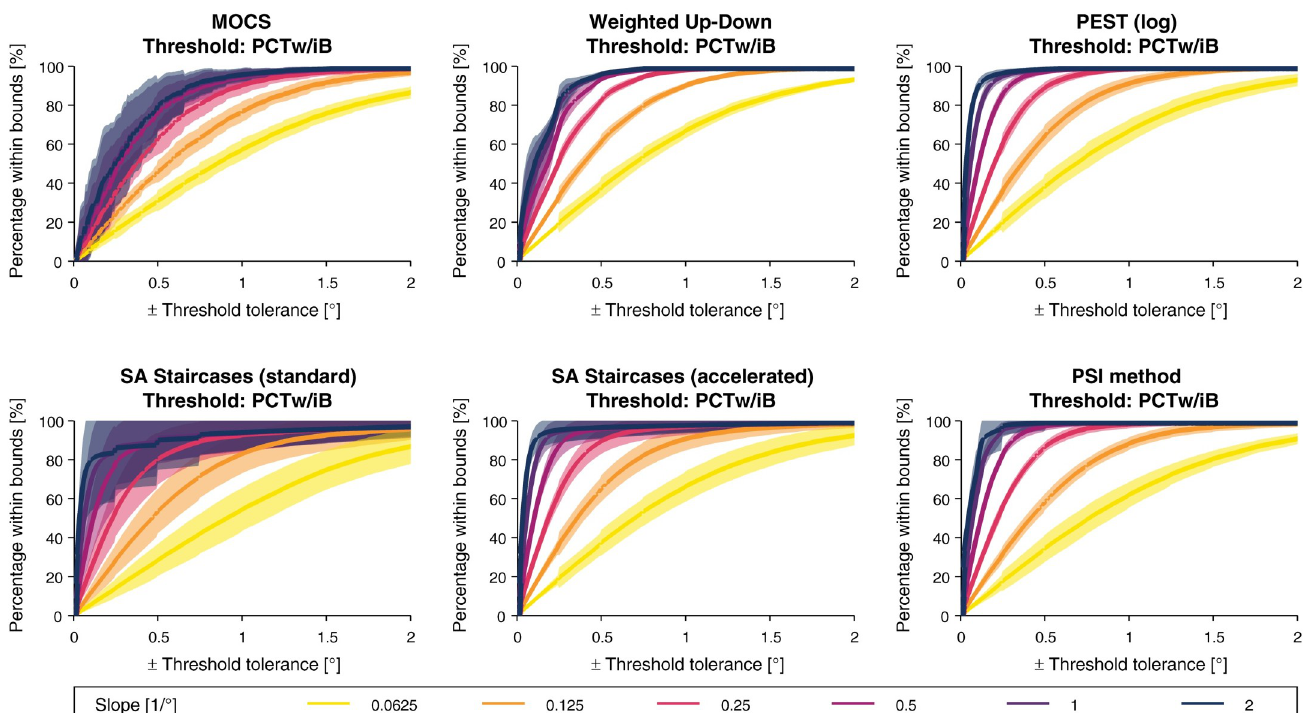
Fig 10. Percentage within bounds for the threshold estimates. For each slope value of the template parameter set, the percentage within bounds ( PCTw/iB ) function for threshold estimation are shown with the mean (bold line) and standard deviation (shaded band) across all modeled thresholds.